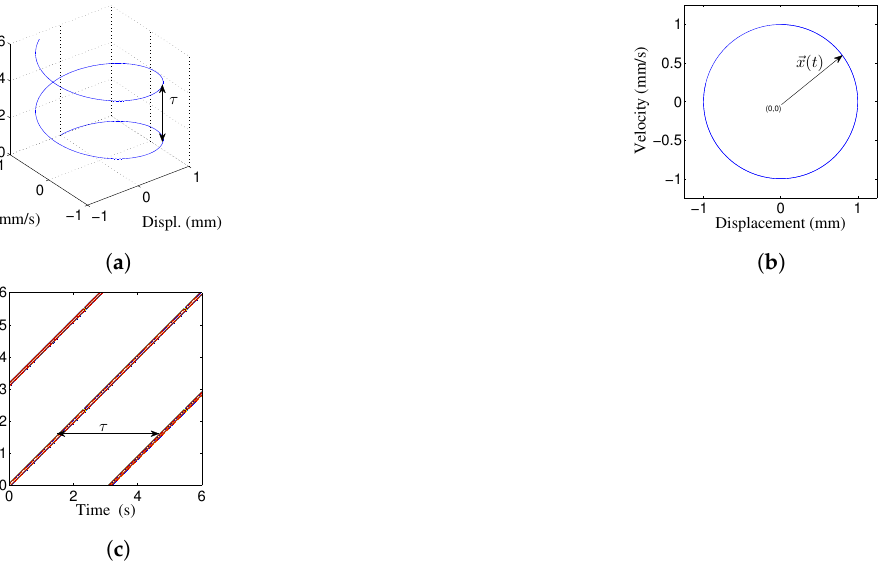
Figure 1. ( a ) Evolution of state variables; ( b ) phase plane; ( c ) recurrence plot ( (cid:101) = 0.1) for the harmonic function: x = sin ( 2 t + φ )